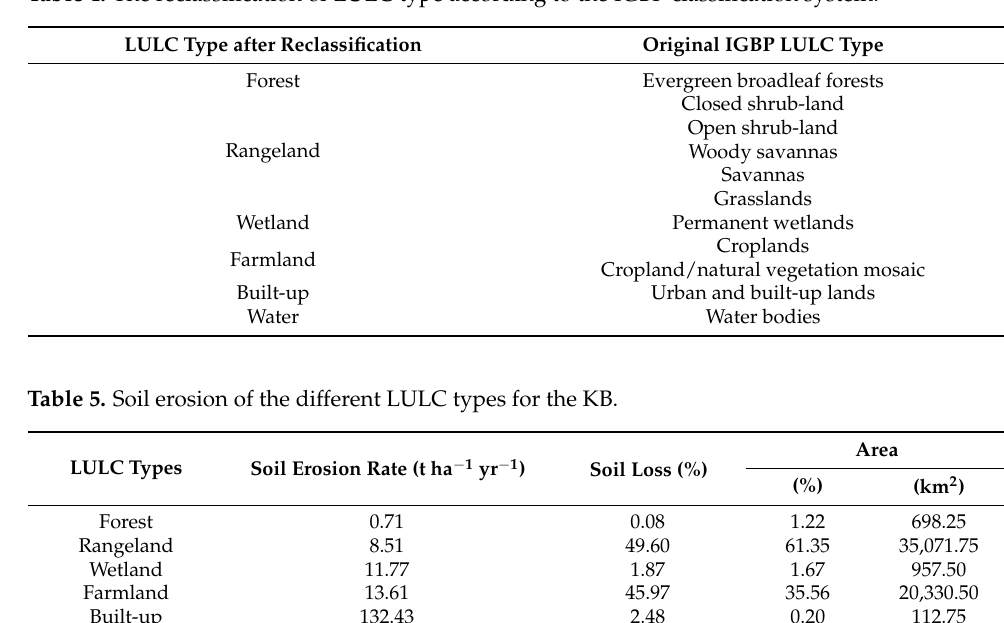
Table 4. The reclassification of LULC type according to the IGBP classification system.